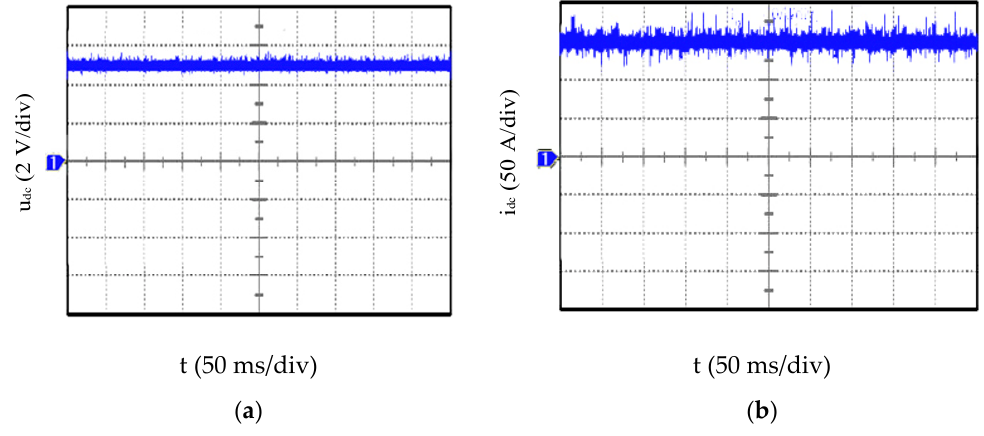
Figure 16. DC output waveform: ( a ) voltage waveform; ( b ) current waveform.